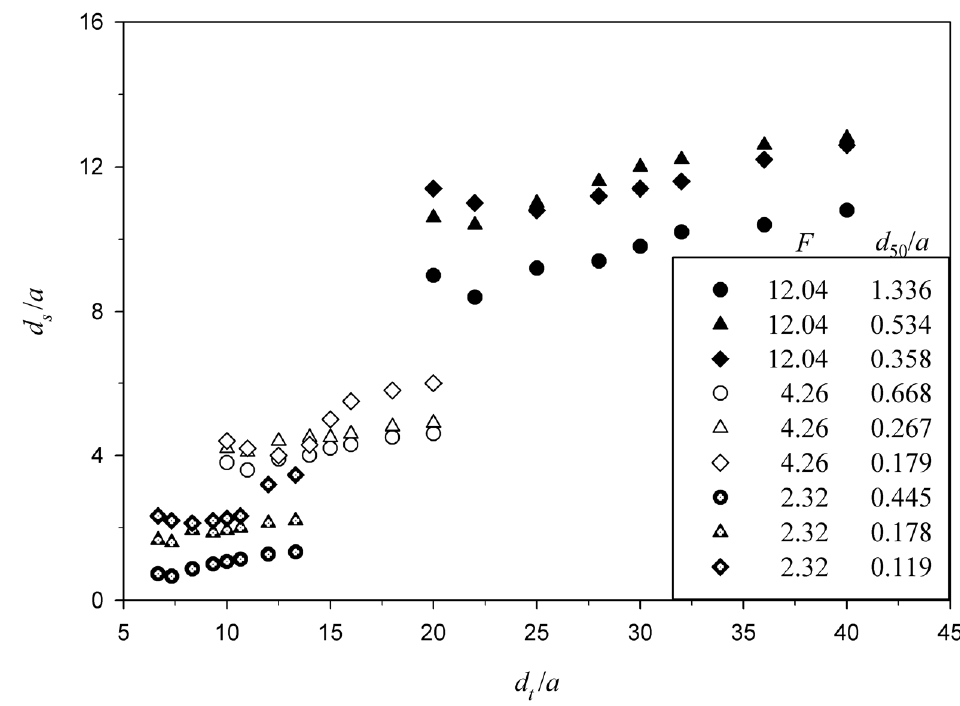
Figure 8. For various F and d 50 , the variation of d s / a with d t /